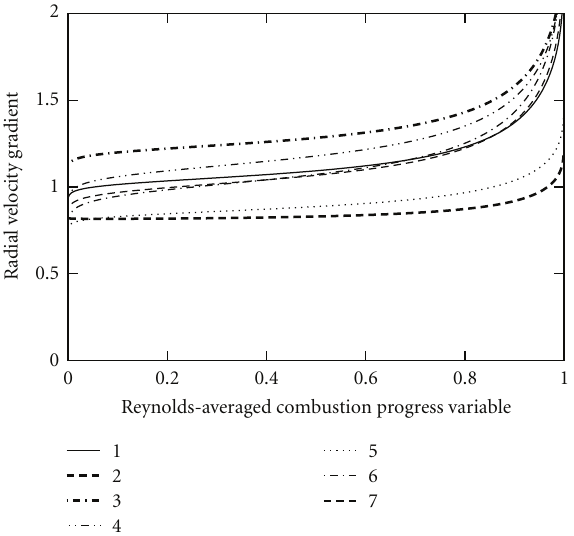
Figure 9: Normalized radial gradient of the Favre-averaged radial velocity versus the Reynolds-averaged combustion progress vari- able. Numbers in legends correspond to flame numbers in Table